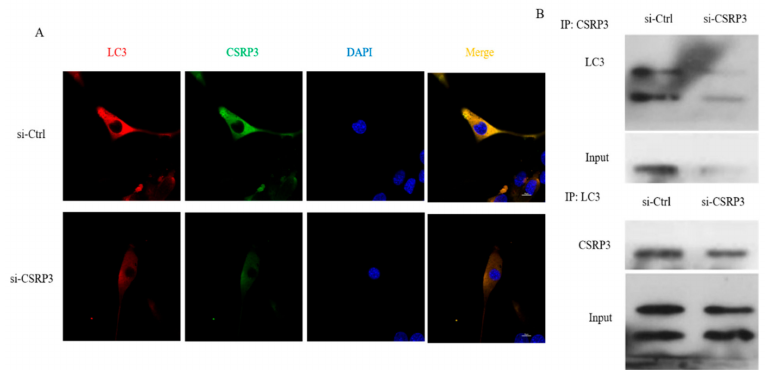
Figure 5. Co-localization of CSRP3 and LC3 in chicken myoblasts. ( A ) Representative confocal microscopy images of LC3 (red) and CSRP3 (green) were shown; scale bar = 20 µ m. ( B ) Reciprocal co-immunoprecipitation analysis between CSRP3 and LC3 in ctrl and CSRP3 siRNA cells. Data are expressed as mean ± SEM of three independent